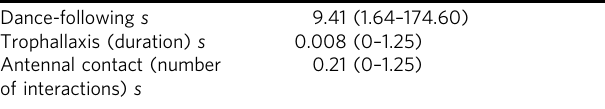
Table 3 Estimated rates of social transmission ( s ) in the recruitment